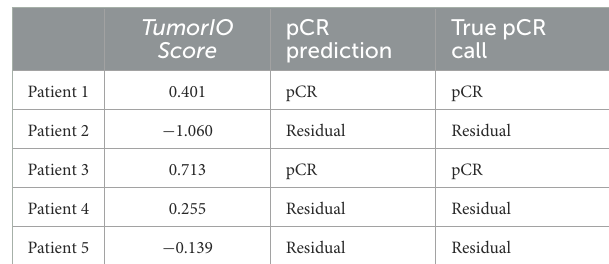
TABLE 2 Prediction of pCR in HR + /HER2- tumors (5/5